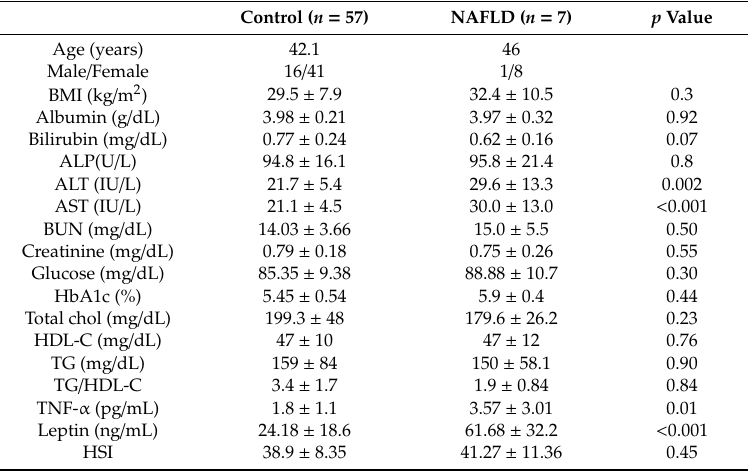
Table 2. Demographics and standard plasma metrics expressed as average ± standard deviation only for samples with glucose cut-o ff ≤ 100 mg /